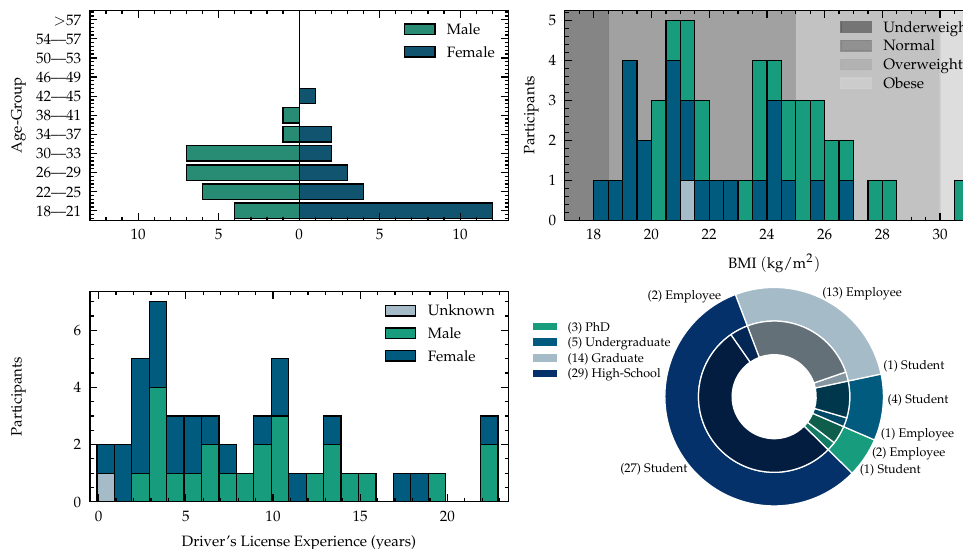
Figure 1. Demographic data was answered by subjects before participation. ( Upper-Left ): Pyramid with age groups over several subjects within that group (One subject did not answer the age and sex questionnaire). ( Upper-Right ): Histogram of BMI with highlighted classes according to WHO healthy lifestyle classification guidelines [55]. ( Lower-Left ): Histogram of driver experience in years. Subjects with no driver’s license have been set to zero years. ( Lower-Right ): Pie-Chart with current occupation (student, employee) within different formal education (high-school, undergraduate, graduate, Ph.D.). Inner-Circle: Occupation, Outer-Circle: Highest Obtained